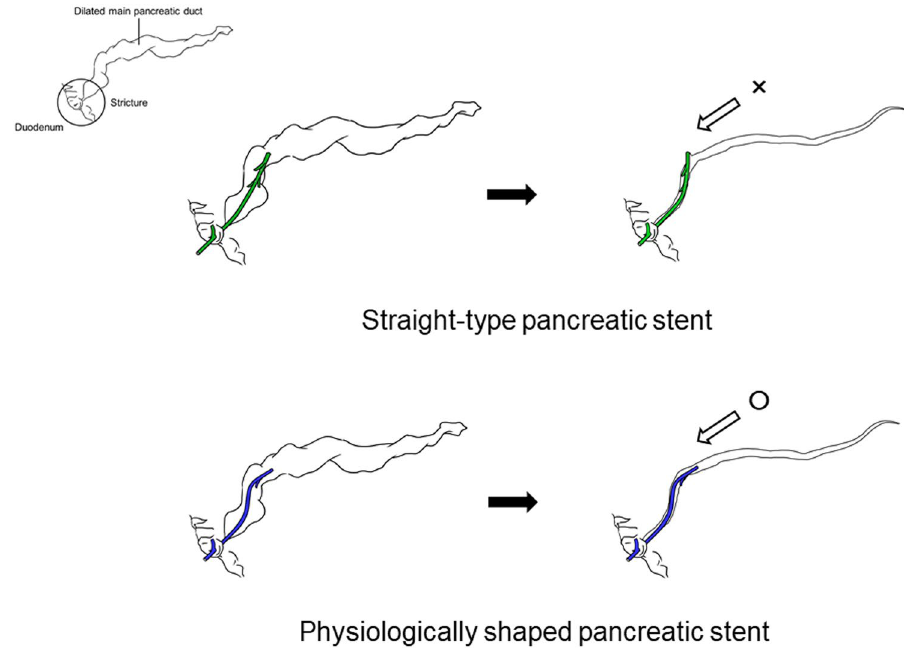
Figure 3. Schematics of the two stents. Initially, both straight-type and physiologically shaped pancreatic stents were inserted correctly. However, after stent insertion, the proximal dilated pancreatic duct shrank and the shape of the proximal MPD changed. The shrunken proximal pancreatic duct does not align with the straight type pancreatic stent, and the proximal side of the stent got stuck. As the stent shape does not follow the MPD, it seems to constitute a similar problem to that of an occlusion. MPD, main pancreatic